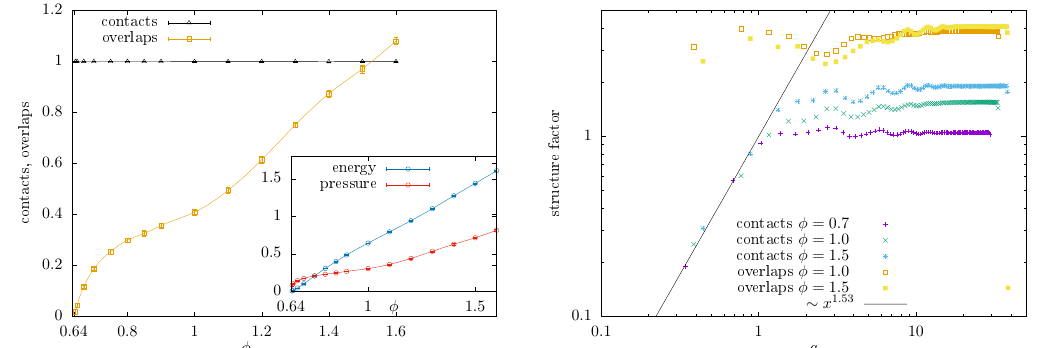
Figure 7: Left panel : isostaticity index and fraction of overlaps. While at all densities the minima are isostatic, the number of overlaps increases monotonically. In the inset, the corresponding energy and pressure. Right panel : structure factor of the local coordination of the contact and overlap network. While fluctuations of the local connectivity of the overlap network follow the central limit theorem, the ones of the contact network are hyperuniform. Data produced with system size N = 1024, dimensions d = 3, averaged over ∼ 30 samples for each density φ .